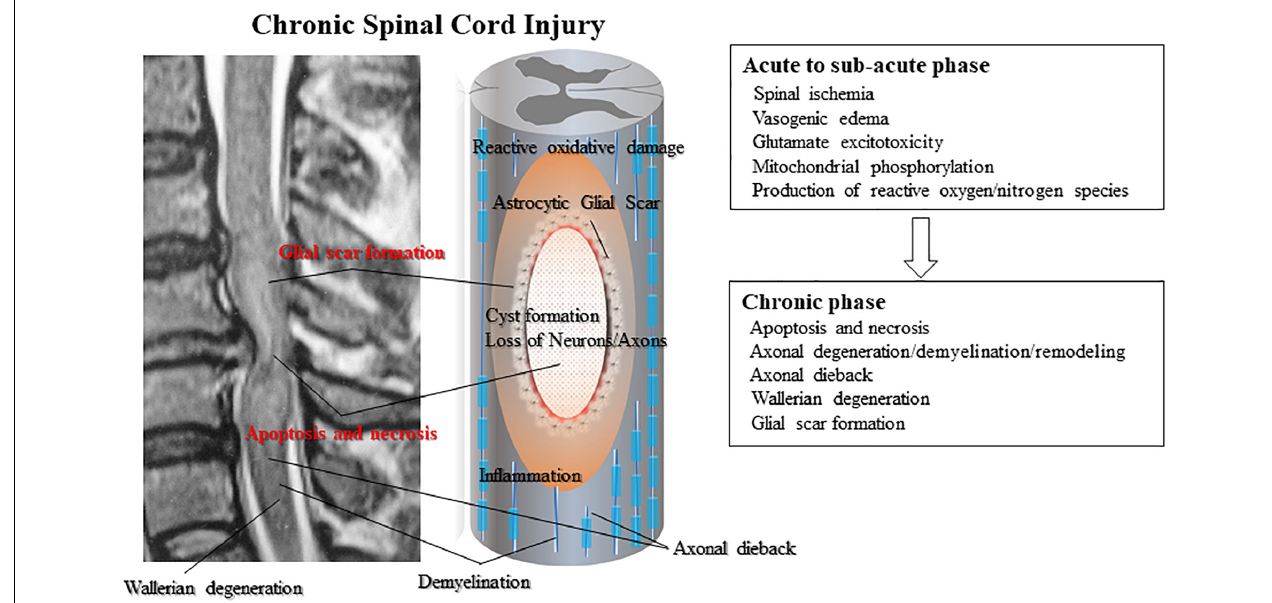
FIGURE 1 | Subsequent secondary injury is characterized by further neuronal/axonal cell death and myelin degradation led by secondary inflammation from infiltrating lymphocytes and monocytes. Activated astrocytes composing the glial scar secret reactive oxygen species that widen the damaged area of the spinal cord. Glial scarring and post-traumatic cyst or syrinx formation create physical impediments to regeneration. Neurons are further damaged by post-traumatic cyst formation that exerts physical pressure on the damaged axons.